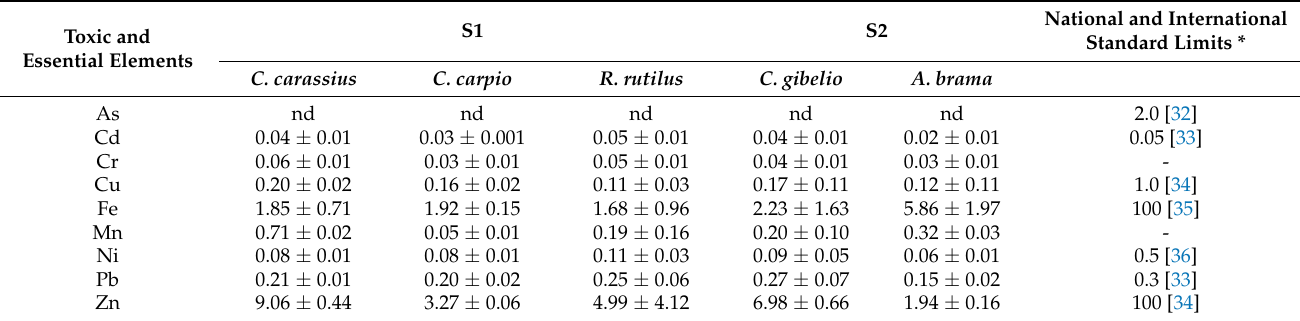
Table 4. Concentration of heavy metals (mean ± standard deviation in mg/kg ww) in freshwater fish species from Lake Mandra and Lake Bourgas (Black Sea,